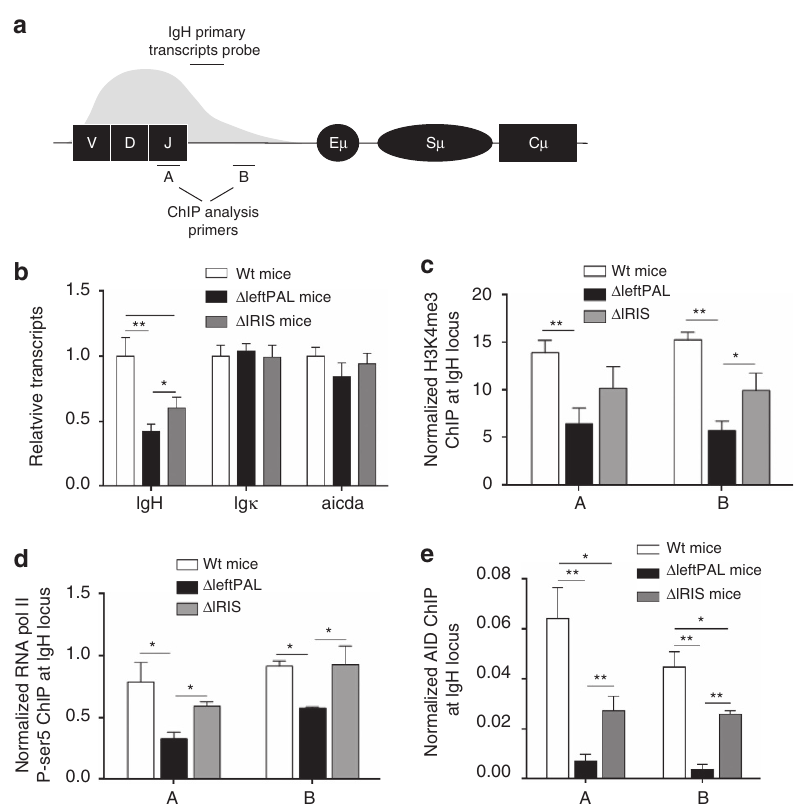
Figure 3 | Mechanism underlying the 3’RR palindromic effect on SHM. ( a ) Locations of probes (A,B) for ChIP experiments and PCR primers for IgH transcription. ( b ): IgH , Ig k and AICDA transcription in D leftPAL, D IRIS and wt mice. Mice were immunised orally with sheep red blood cells for 2 weeks and intraperitoneally with 10 m g of LPS for 3 days. Peyer’s patch cell RNA was extracted and transcripts were amplified by real-time PCR. Data are the mean ± s.e.m. of six independent experiments with one mouse per genotype (8–12 weeks old, male and female). * P o 0.05 and ** P o 0.001 (Mann–Whitney’s U -test for significance). Values were normalised to GAPDH transcripts. ( c ) ChIP analysis of H3K4me3 in V H regions in Peyer’s patch cells in D leftPAL, D IRIS and wt mice. Background ChIP signals from mock samples with irrelevant antibody were subtracted. ChIP values were normalised to the total input DNA. Data are the mean ± s.e.m. of four independent experiments (8- to 12-week-old mice, male and female). * P o 0.05, ** P o 0.01 (Mann–Whitney U -test). ChIP experiments were done in A and B locations (as in a ). Same immunisation protocol as in b . ( d ) ChIP analysis of pol II paused in V H regions in Peyer’s patches cells in D leftPAL, D IRIS and wt mice. Data are the mean ± s.e.m. of four independent experiments (8- to 12-week-old mice, male and female). * P o 0.05, ** P o 0.01 (Mann–Whitney U -test). Same immunisation protocol as in b . ( e ) ChIP analysis of AID recruitment in V H regions in Peyer’s patch cells in D leftPAL, D IRIS and wt mice. Data are the mean ± s.e.m. of five independent experiments (8- to 12-week-old mice, male and